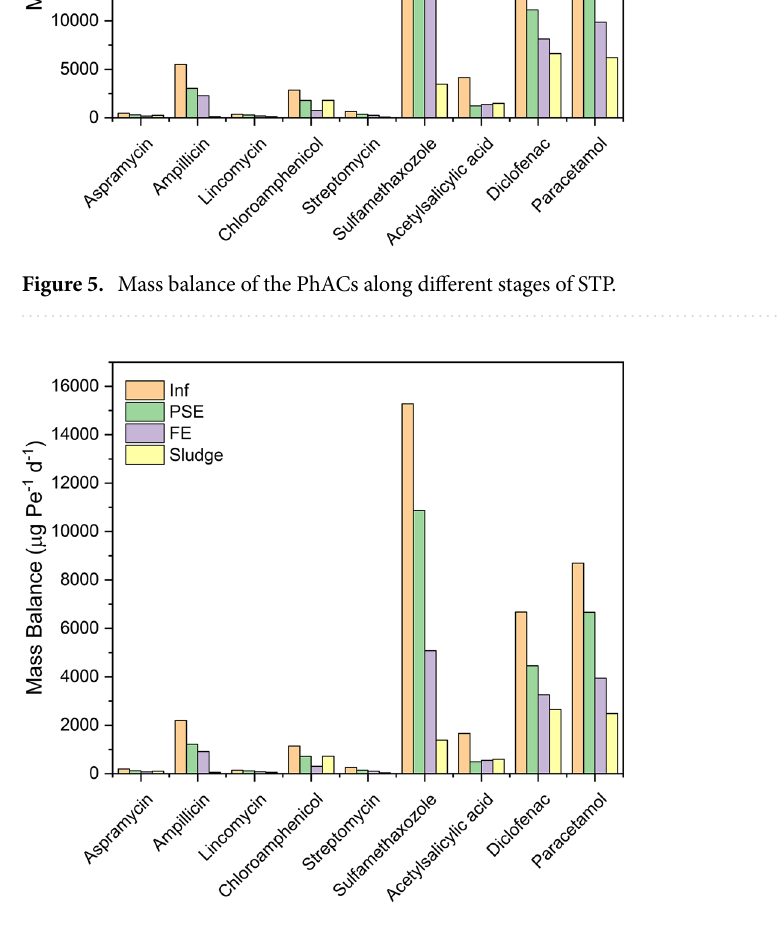
Figure 6. Personal mass load of the PhACs along the different stages of